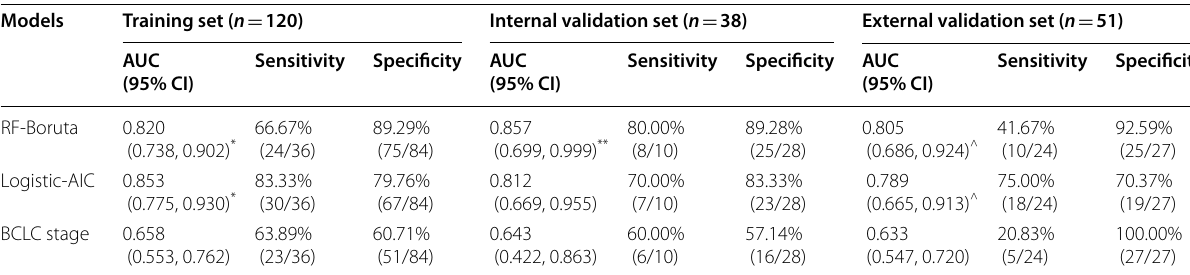
Table 4 Prediction performance of the two developed models and the BCLC stage